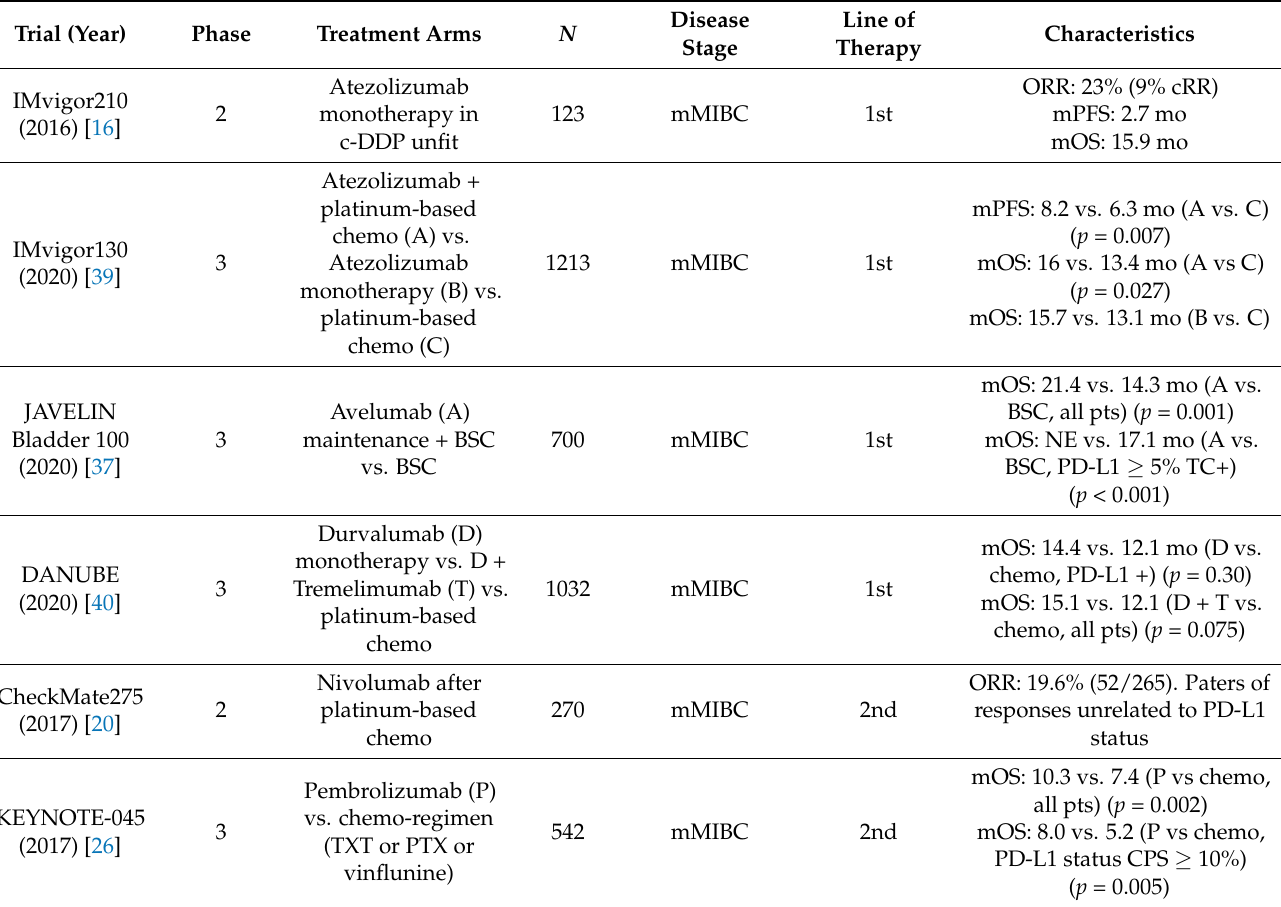
Table 1. Overview of immune checkpoint trials in bladder